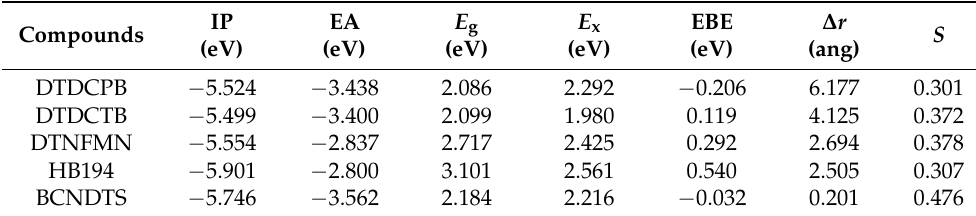
Table 2. Calculated exciton binding energy and related parameters in solid state based on the solvation model.